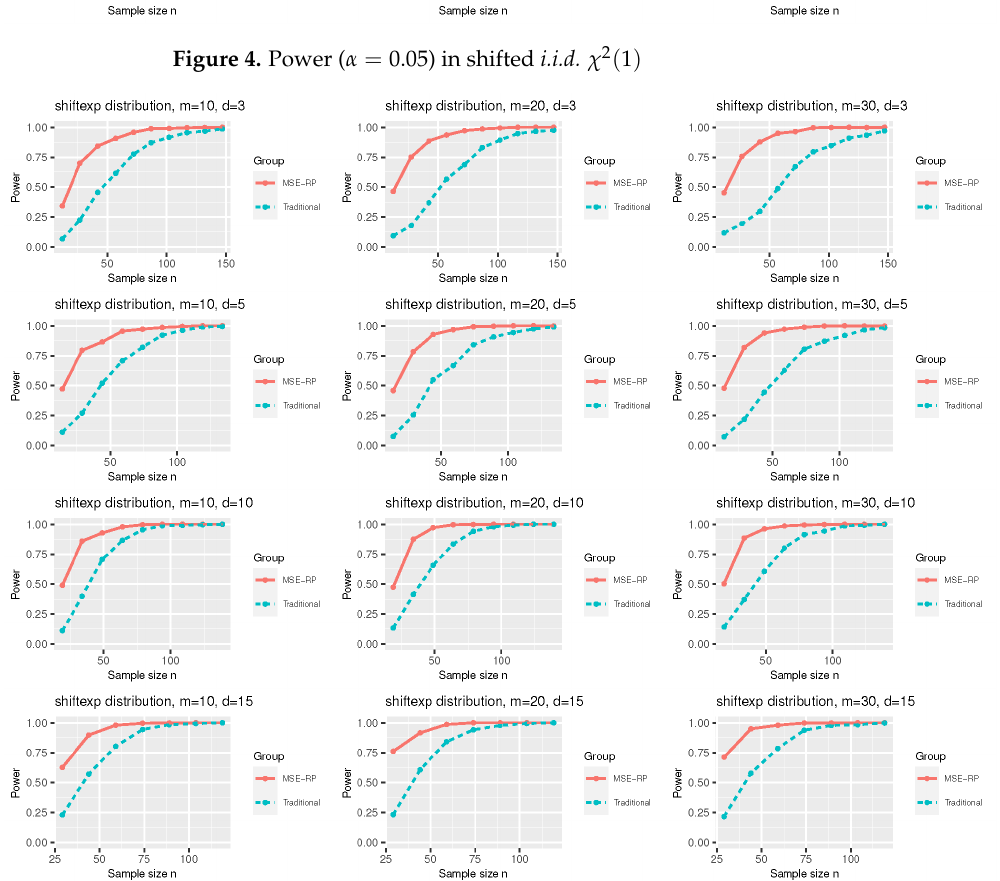
Figure 4. Power ( α = 0.05) in shifted i.i.d. χ 2 ( 1 )